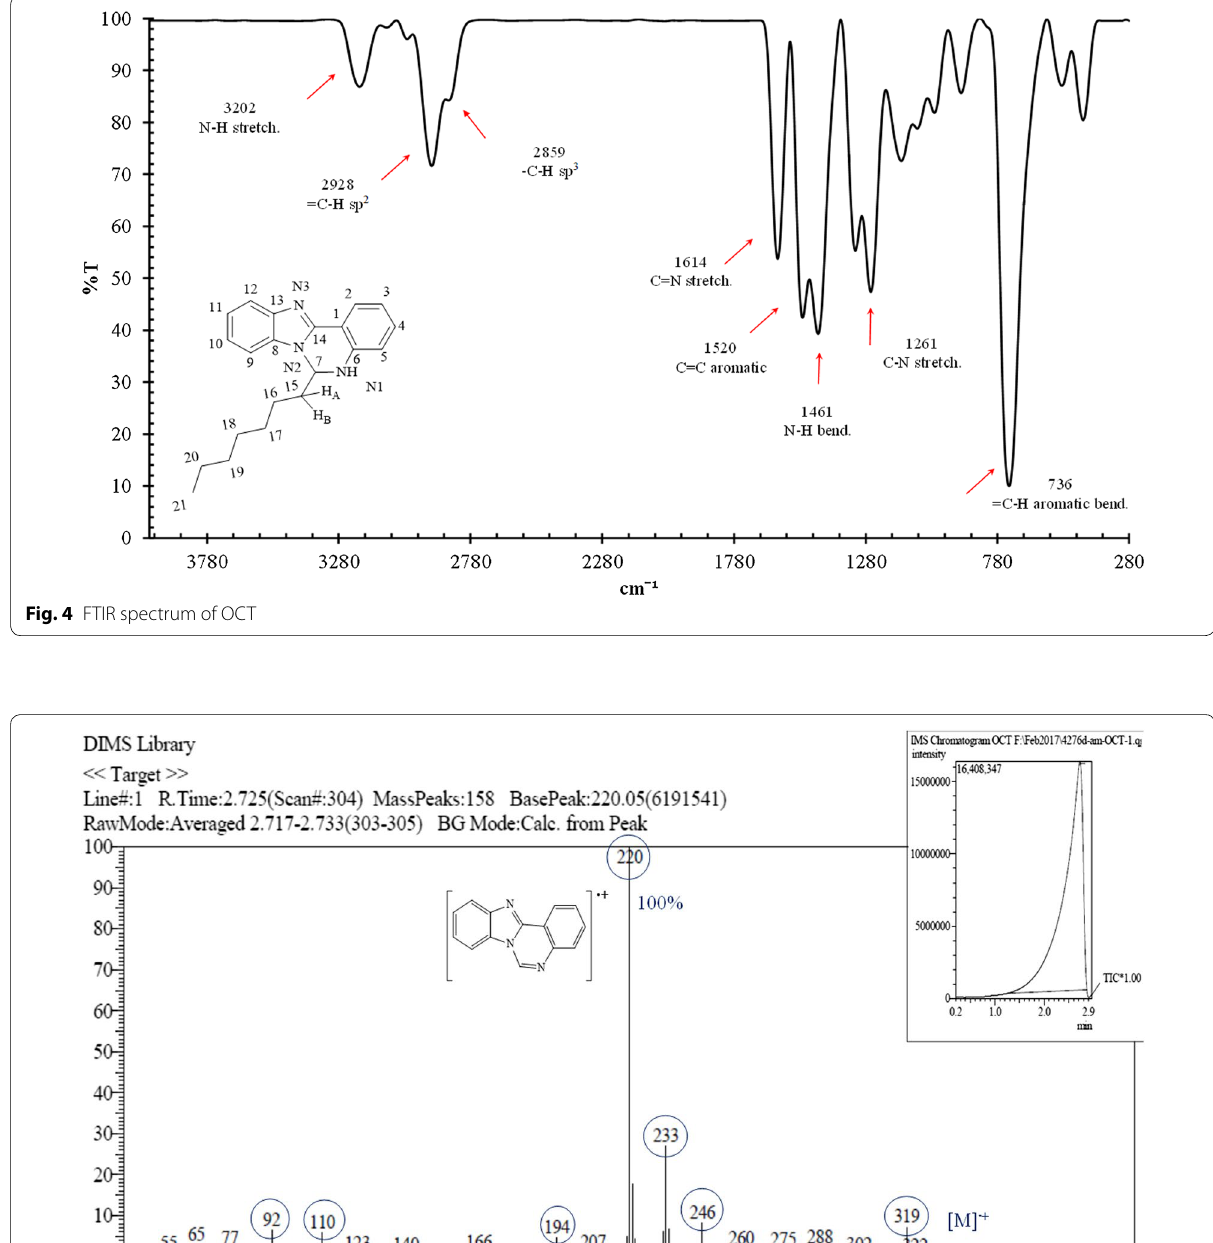
where, α measured optical rotation. T = ture at measurement process. λ nm, 589 nm using a D line of sodium. l cell length in decimetre. c g/mL.